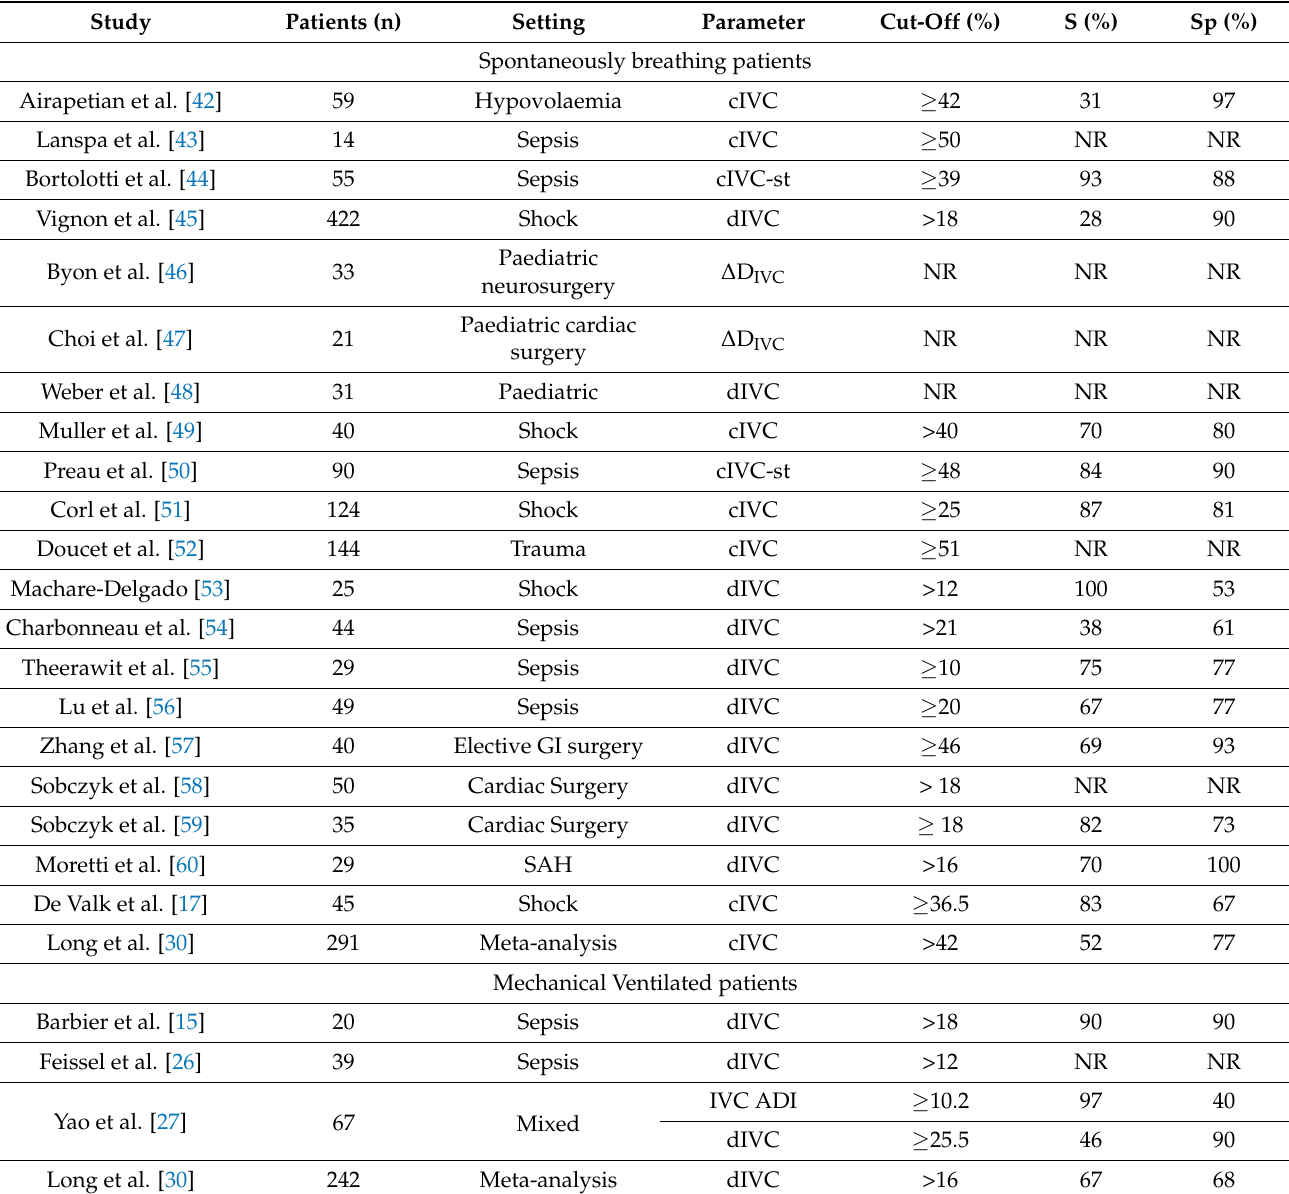
Table 1. Fluid responsiveness in spontaneous breathing or mechanical ventilated